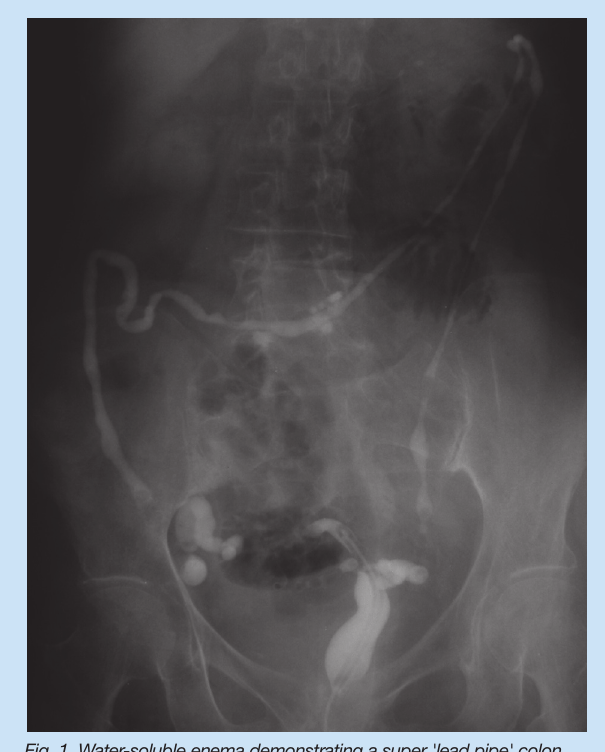
Fig. 1. Water-soluble enema demonstrating a super 'lead pipe' colon.